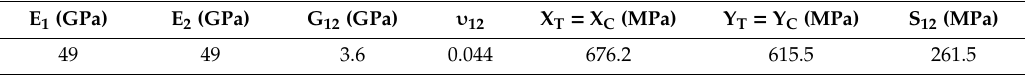
Table 1. The mechanical parameters of plain carbon fabric prepreg.